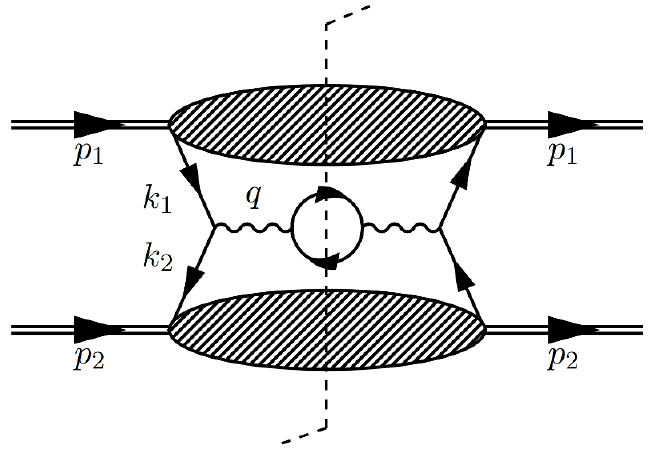
Figure 5 . The dominant contribution to the DY hadronic tensor (4.3). The dashed line bisecting the graph denotes a sum over all unobserved hadronic (cid:12)nal